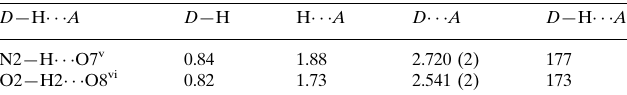
Hydrogen-bond geometry (A˚ , (cid:4)